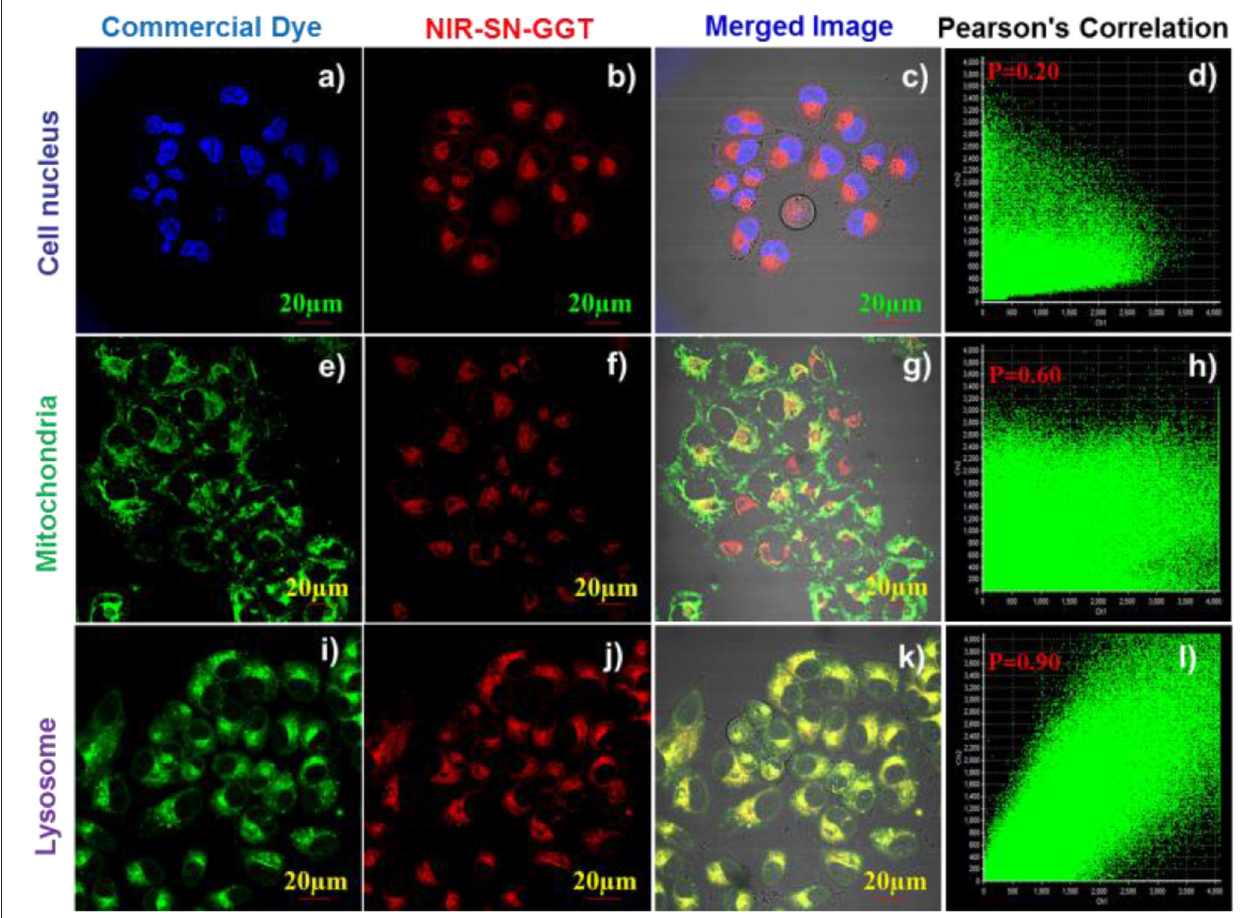
FIGURE 6 | Fluorescence imaging of subcellular localization in living A2780 cells. A2780 cells were treated with 5 µ M probe NIR-SN-GGT for 20min and the co-incubated 0.1 µ M Hoechst 33342 (a–d) , 0.5 µ M Mito-Tracker (e–h) , 0.5 µ M Lyso-Tracker (i–l) for another 15min at 37 ◦ C. The blue channel of Hoechst 33342 dye was collected at 410-480nm with the excitation at 405nm. The green channel of Mito-Tracker and Lyso-Tracker dyes were collected at 500-560nm with the excitation at 488nm. The red channel of probe NIR-SN-GGT was collected at 655-755nm with the excitation at 488nm. Scale bar = 20 µ m.